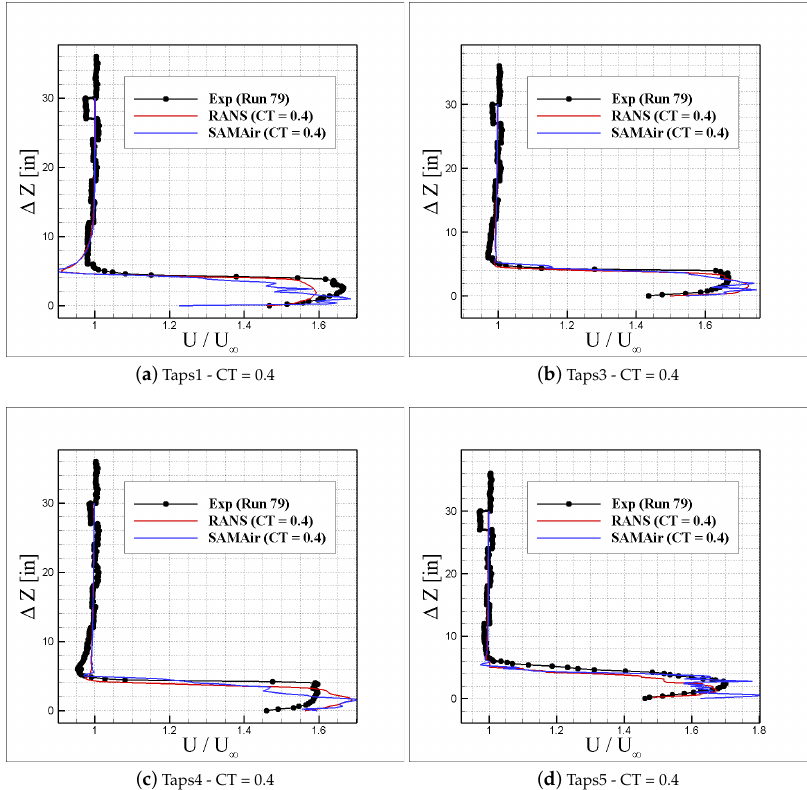
Figure 18. Wake survey validation of x-velocity for wing propeller at CT = 0.4 and α = 0 ◦